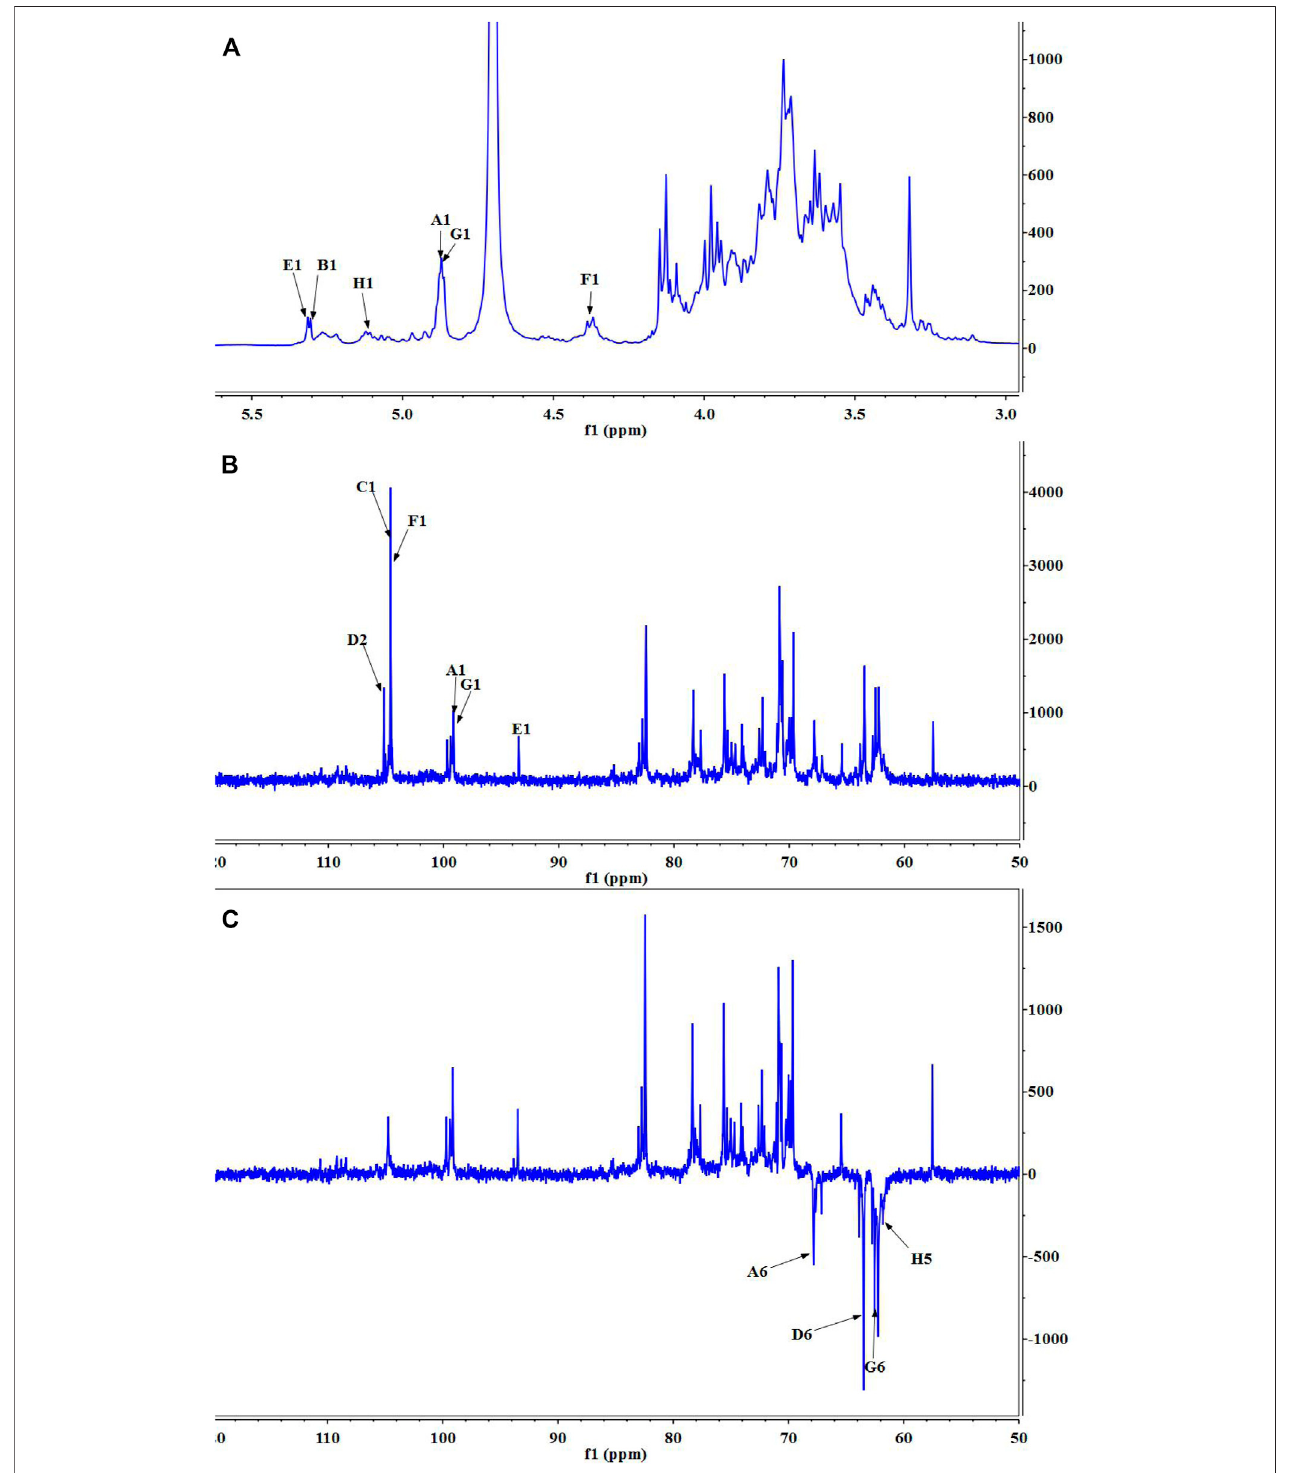
FIGURE3| 1DNMRspectraofLHPW: (A) 1 HNMR, (B) 13 CHMR,and (C) DEPT135.Sameas Table2 ,A – Hrepresent theGlycosylresidues → 6)- α -D-Galp-(1 → , → 4)- α -D-Glcp-(1 → , → 3,6)- β -D-Galp-(1 → , → 1)- β -D-Fruf-(2 → , α -D-Glcp-(1 → , → 4)- β -D-Galp-(1 → , α -D-Galp-(1 → , α -L-Araf-(1 → . The number 1 – 6 represent the location of hydrogen or carbon in the Glycosyl